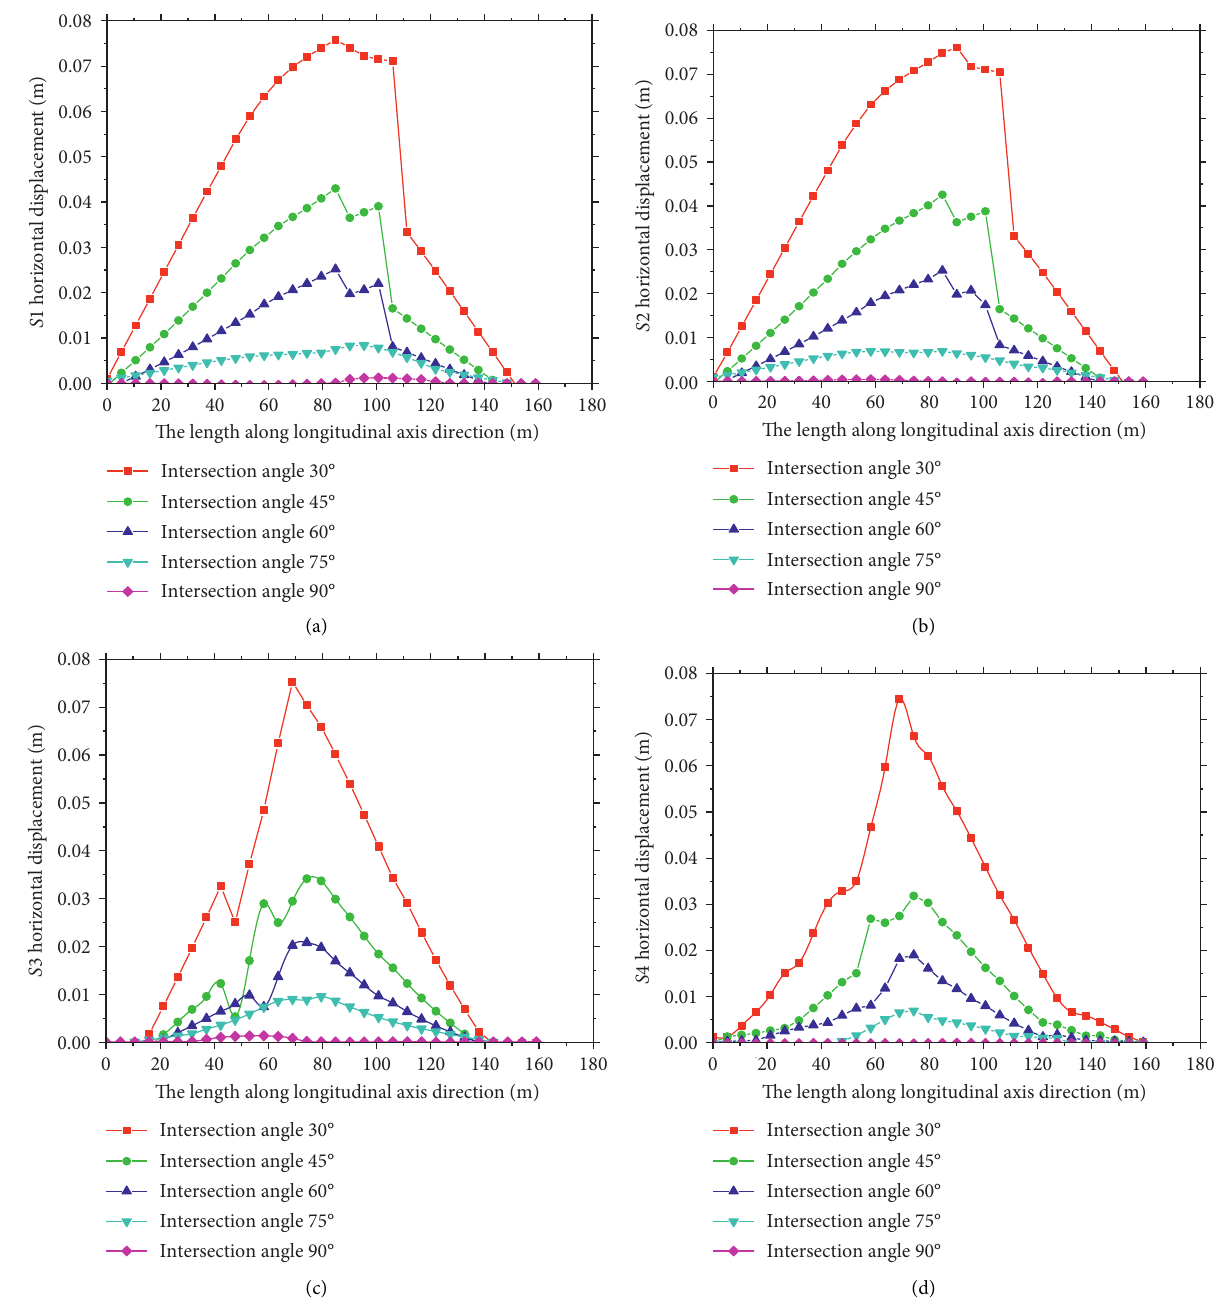
Figure 8: Vertical displacement with different intersection angle. (a) The vertical displacement of surveying line 1. (b) The vertical displacement of surveying line 2. (c) The vertical displacement of surveying line 3. (d) The vertical displacement of surveying line